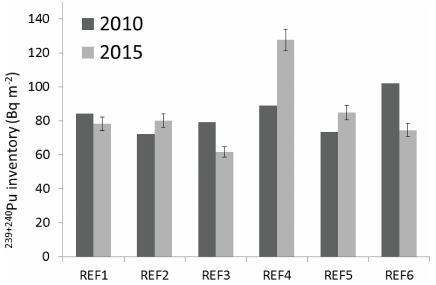
Figure 8. Temporal variation between the total 239 + 240 Pu invento- ries measured at the reference sites in the Urseren Valley; time 0 = 2010 and time 1 = 2015. The error bars indicate the standard de- viations of the inventories among the replicates collected at each reference site in